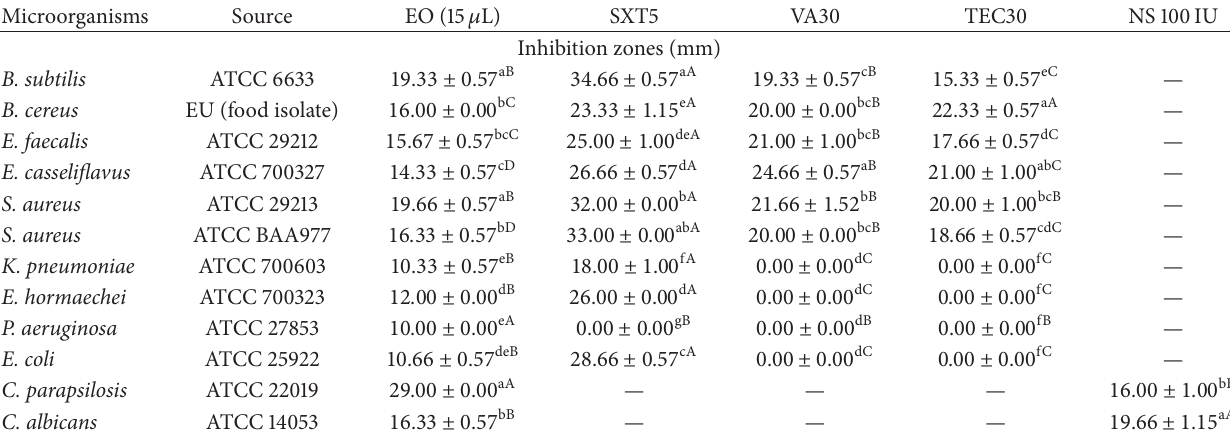
Table 4: Antimicrobial activities of the EO from T. cilicicum using disc diffusion assay. Microorganisms